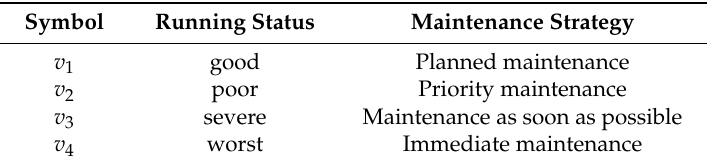
Table 1. Transformer running status and corresponding maintenance